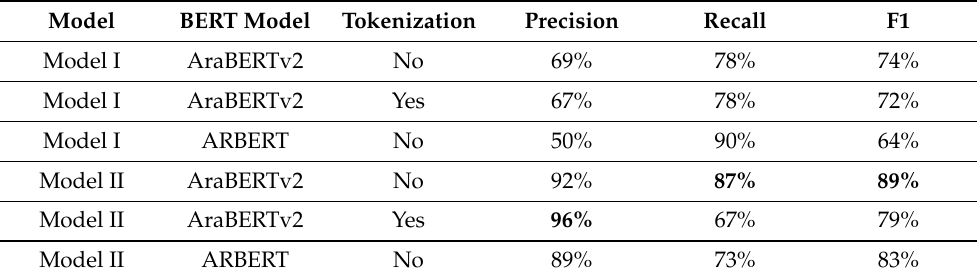
Table 8. Model I versus Model